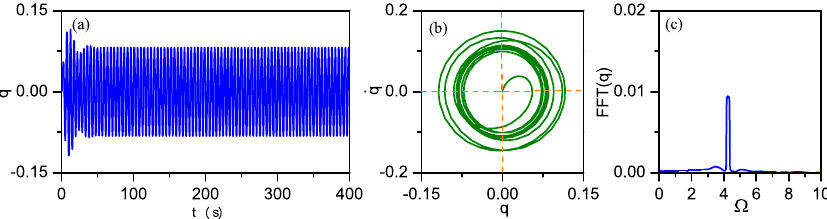
Figure 7. The curves of the critical force amplitude and peak of the primary resonance relate with time delay.